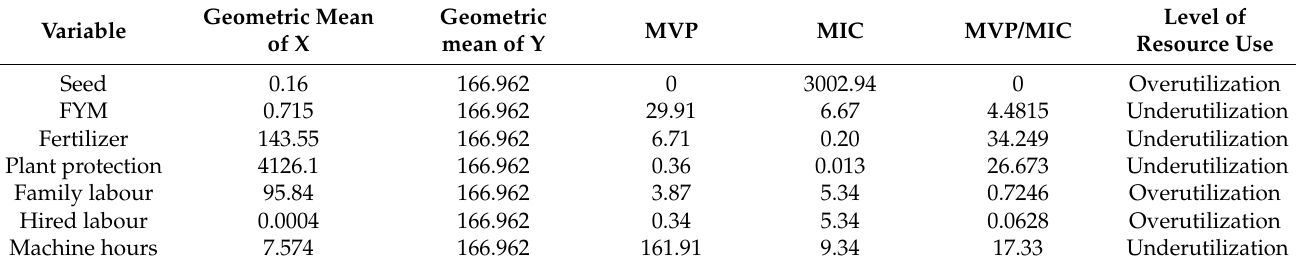
Table 9. Resource use efficiency of marigold cultivation in Jammu district.